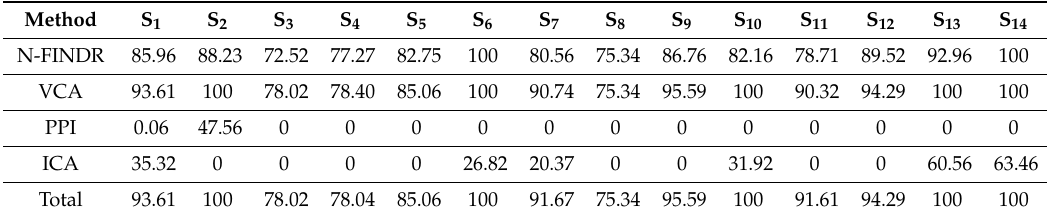
Table 3. Accuracy of vessel detection rate (%) of each ship from S 1 to S 14 to hyperspectral mixture analysis methods such as N-FINDR, VCA, PPI, and ICA, where ‘Total’ represents the errors for integrating all results of the four